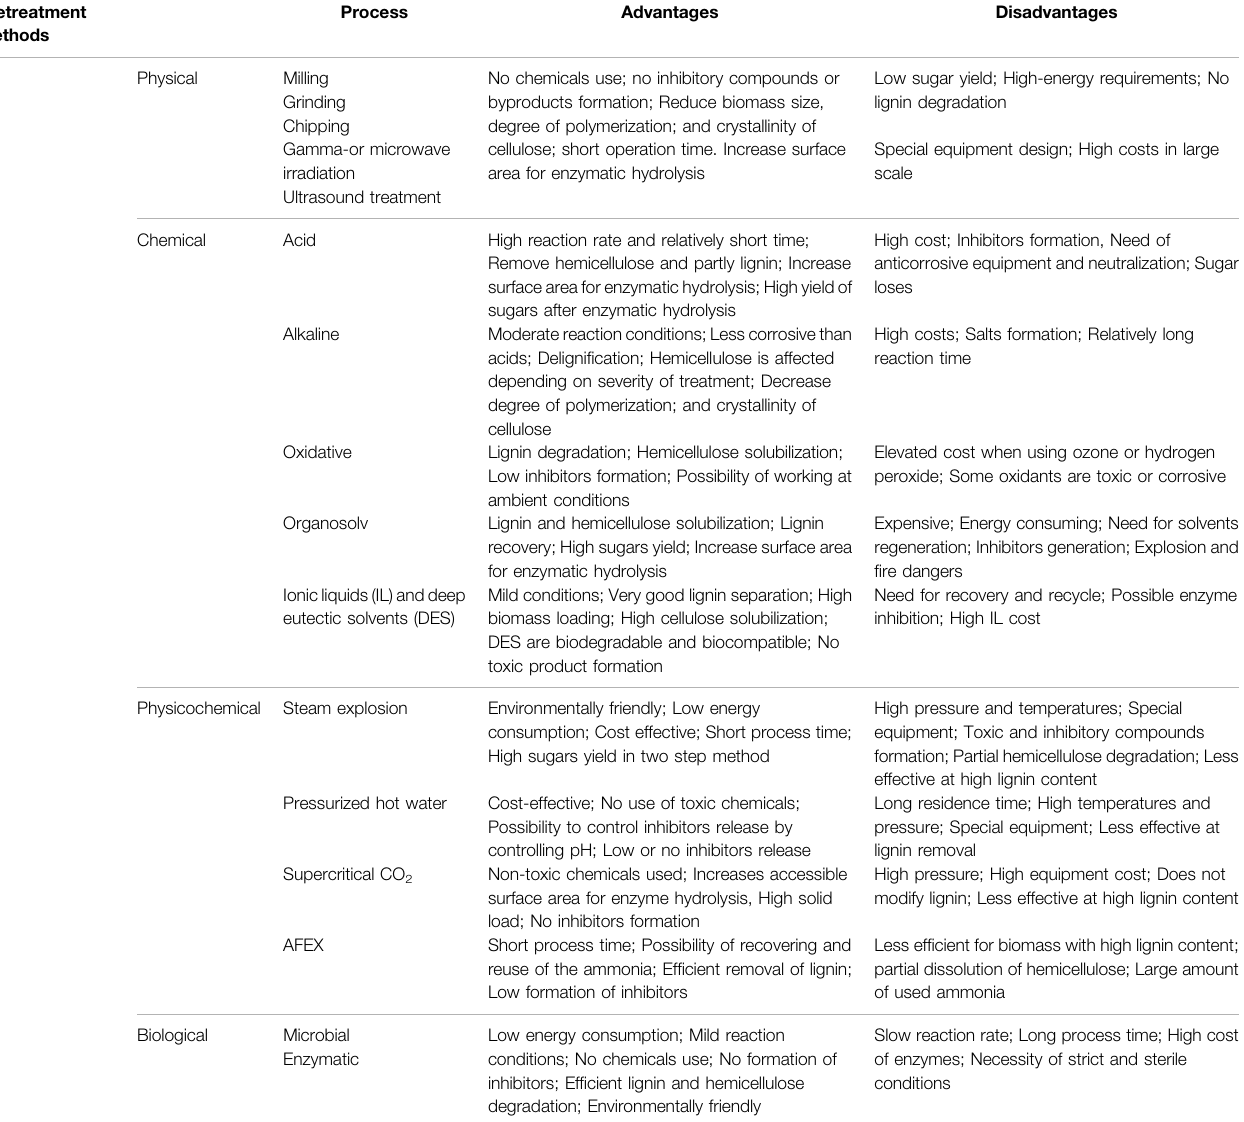
TABLE 2 | Advantages and disadvantages of different pretreatment